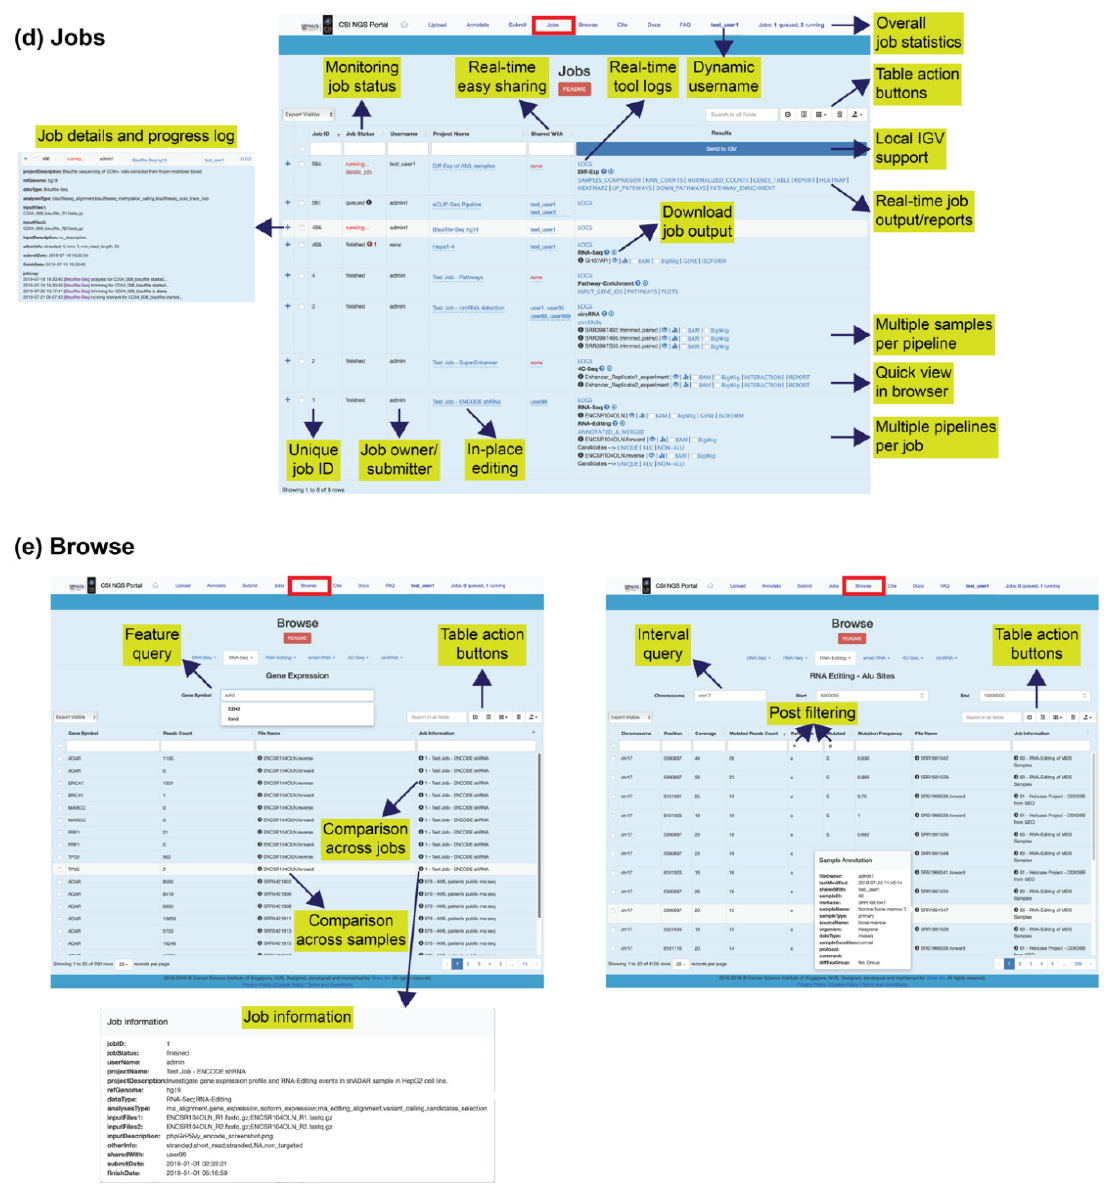
Figure 2. Website Interface and Usage of CSI NGS Portal. ( a ) Upload page, ( b ) Annotation page, ( c ) Submit page, ( d ) Jobs page, and ( e ) Browse page. Key features and usage information are